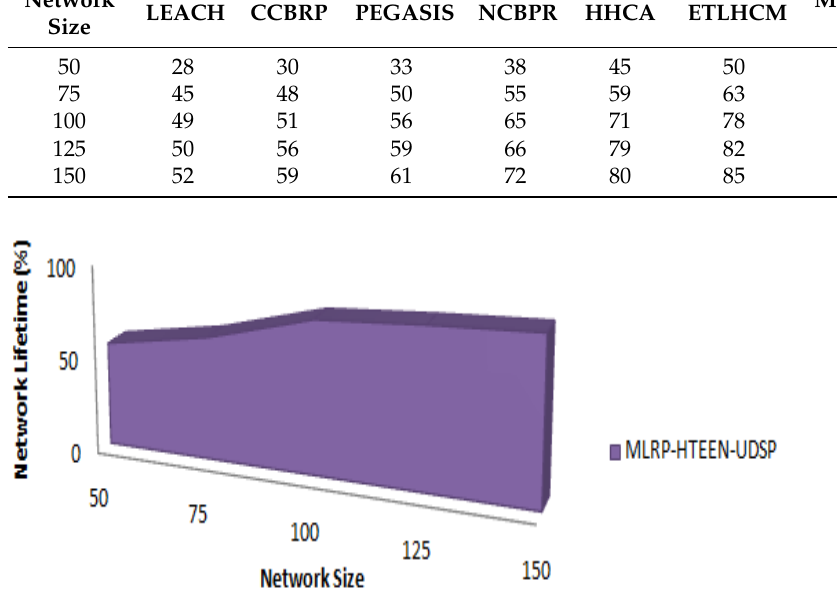
Figure 9. Network lifetime of MLRP-HTEEN-UDSP.